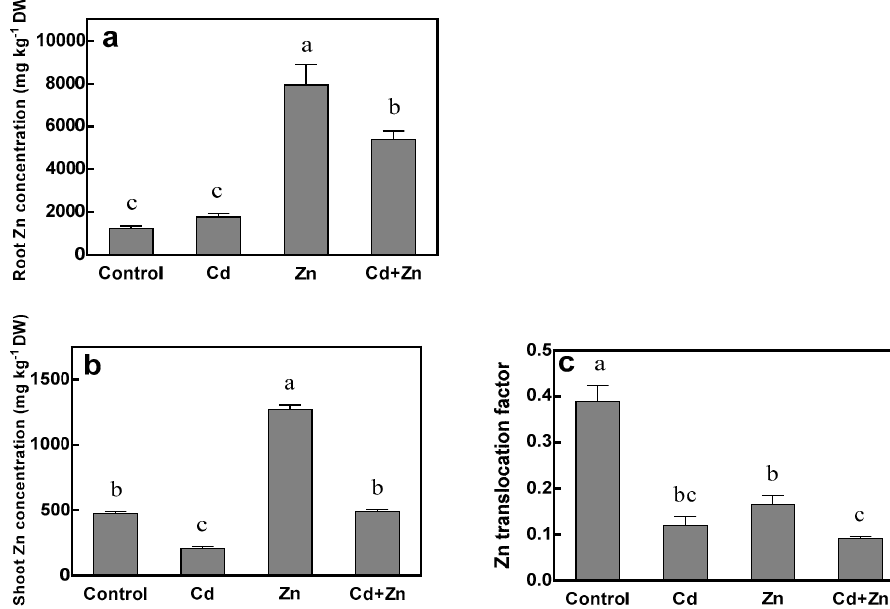
Figure 3. Zn concentrations of root ( a ) and shoot ( b ), and Zn translocation factor ( c ) of tall fescue. Plants were grown for 15 days in solutions under control (0 µ M Cd + 15 µ M Zn), Cd (75 µ M Cd + 15 µ M Zn), Zn (0 µ M Cd + 115 µ M Zn) and Cd + Zn (75 µ M Cd + 115 µ M Zn) treatments. Error bars represent ± SEM of three replicates. Means with a common letter did not di ff er significantly (Duncan’s test, p < 0.05). The two-way analysis was performed.